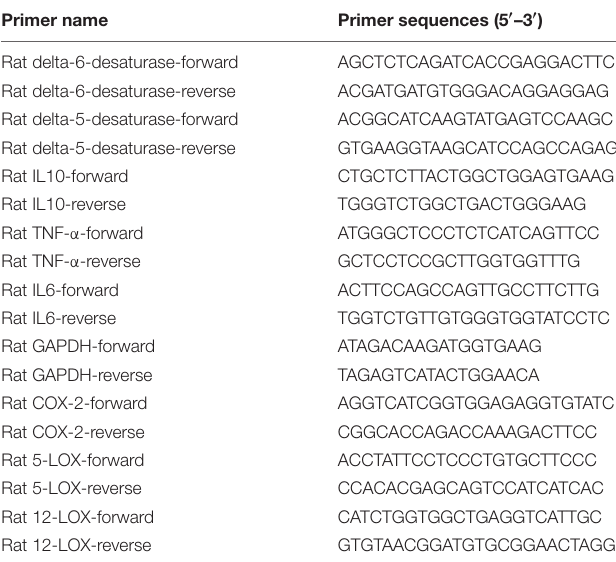
TABLE 1 | Primers used for